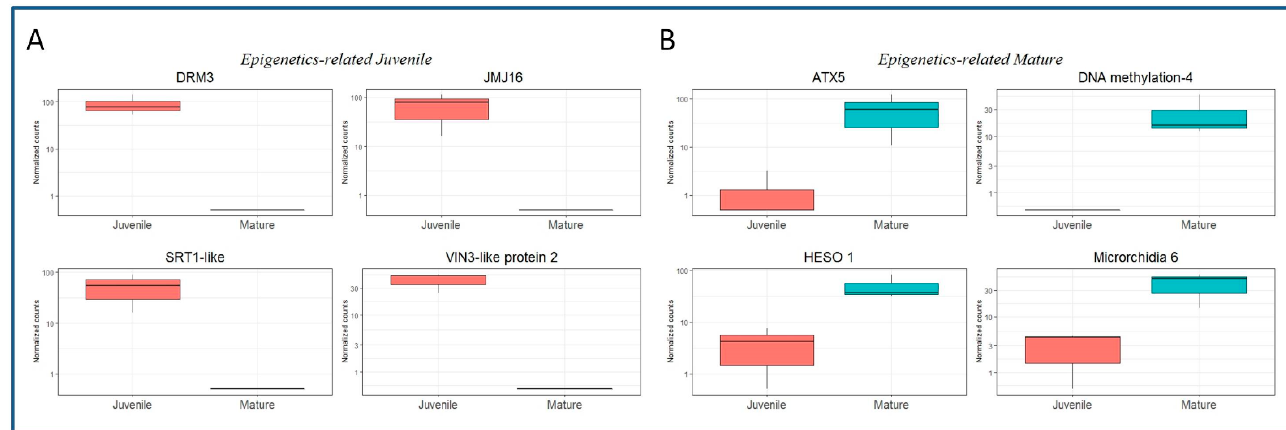
Figure 4. Boxplots showing the expression in normalized counts of DEGs related to epigenetics mechanisms. ( A ) DEGs in the BS samples. DNA (cytosine-5)-methyltransferase DRM3 , LOC112032791; Lysine-specific demethylase JMJ16 , LOC112019264; NAD-dependent protein deacetylase SRT1 , LOC112028975; VIN-3-like protein 2 ( VIL2 ), LOC112021978. ( B ) DEGs in the CR samples. Histone- lysine N-methyltransferase ATX5 , LOC112017971; DNA-methylation Factor 4 , LOC111987241; HESO-1 , LOC111999674; Microrchidia 6 ,